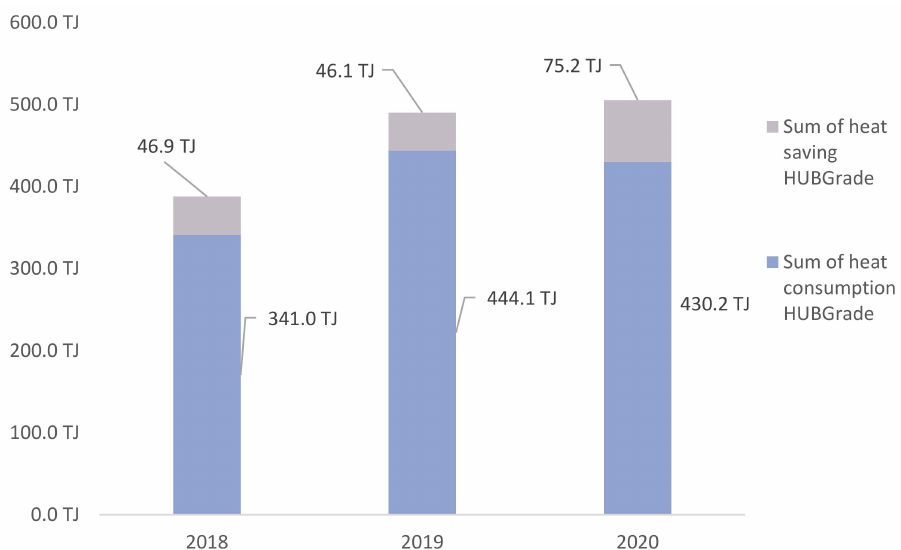
Figure 3. The levels of heat consumption and savings in the period from 2018 to 2020 relative to the baseline in the district heating network in Warsaw. Own elaboration based on data from Hubgrade UBGRADE in Warsaw.